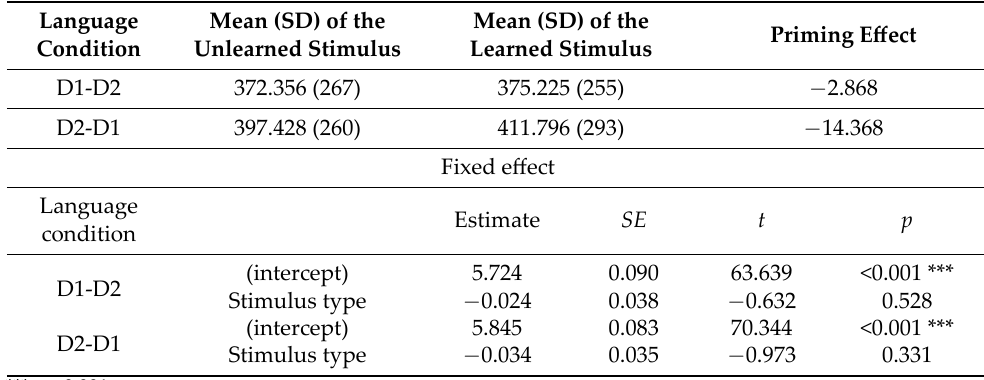
Table 4. Reaction times and the mixed‑effect modeling results for the